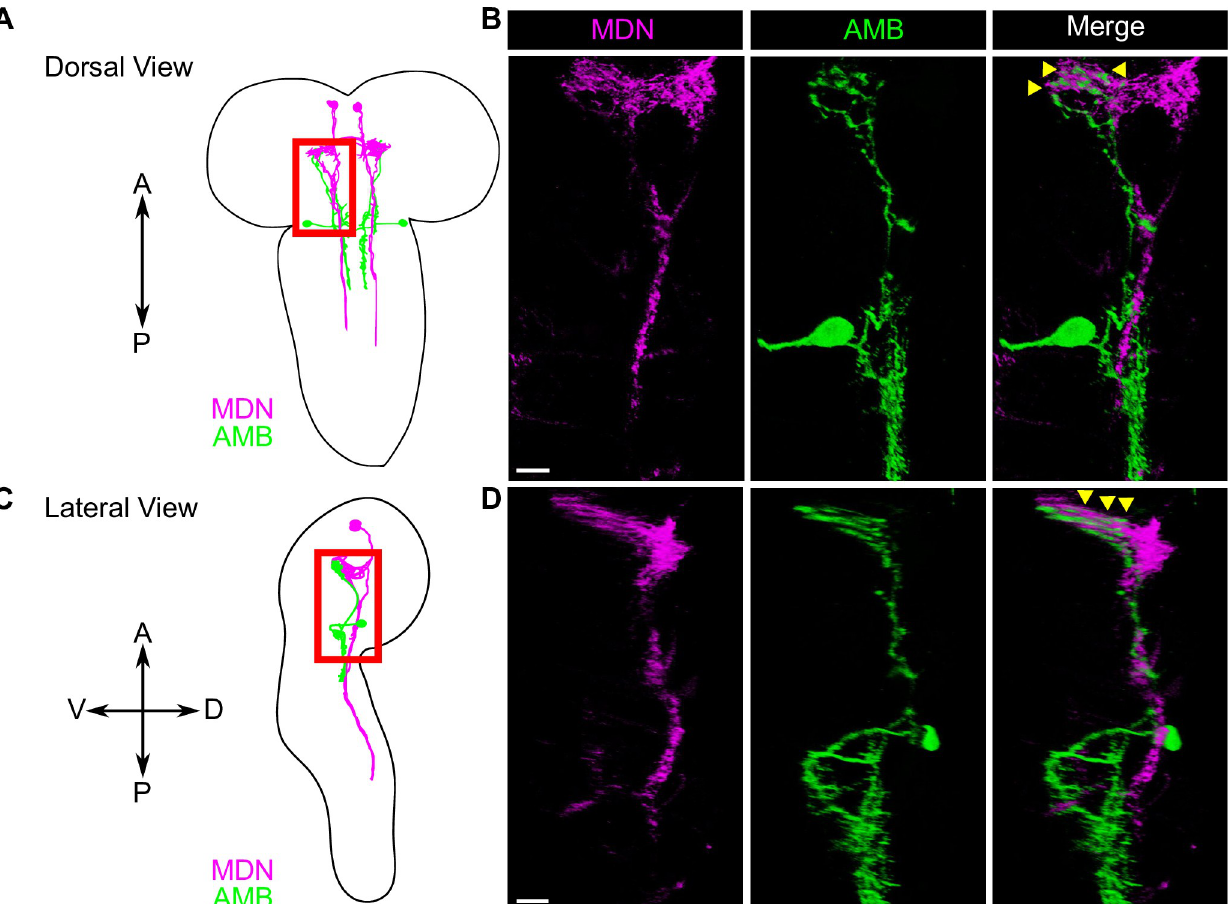
Fig 4. AMB axons are apposed to MDN dendrites in the larval brain. (A-D) A schematic view of AMBs and MDNs from the dorsal (A) and from lateral side (C). The area with red boxes in (A) and (C) were shown in (B) and (D), respectively. Dual-labeling of AMBs (green) and MDNs (magenta). AMBs and MDNs were co-labeled with membrane-localized RFP and membrane-localized GFP, respectively. Genotypes: w ; R60F09-LexA , tsh-GAL80 / LexAop- rCD2RFP ; R73F04-GAL4 , Gad1-2A-GAL80 / UAS-mCD8GFP . Scale bars, 10 μ m.